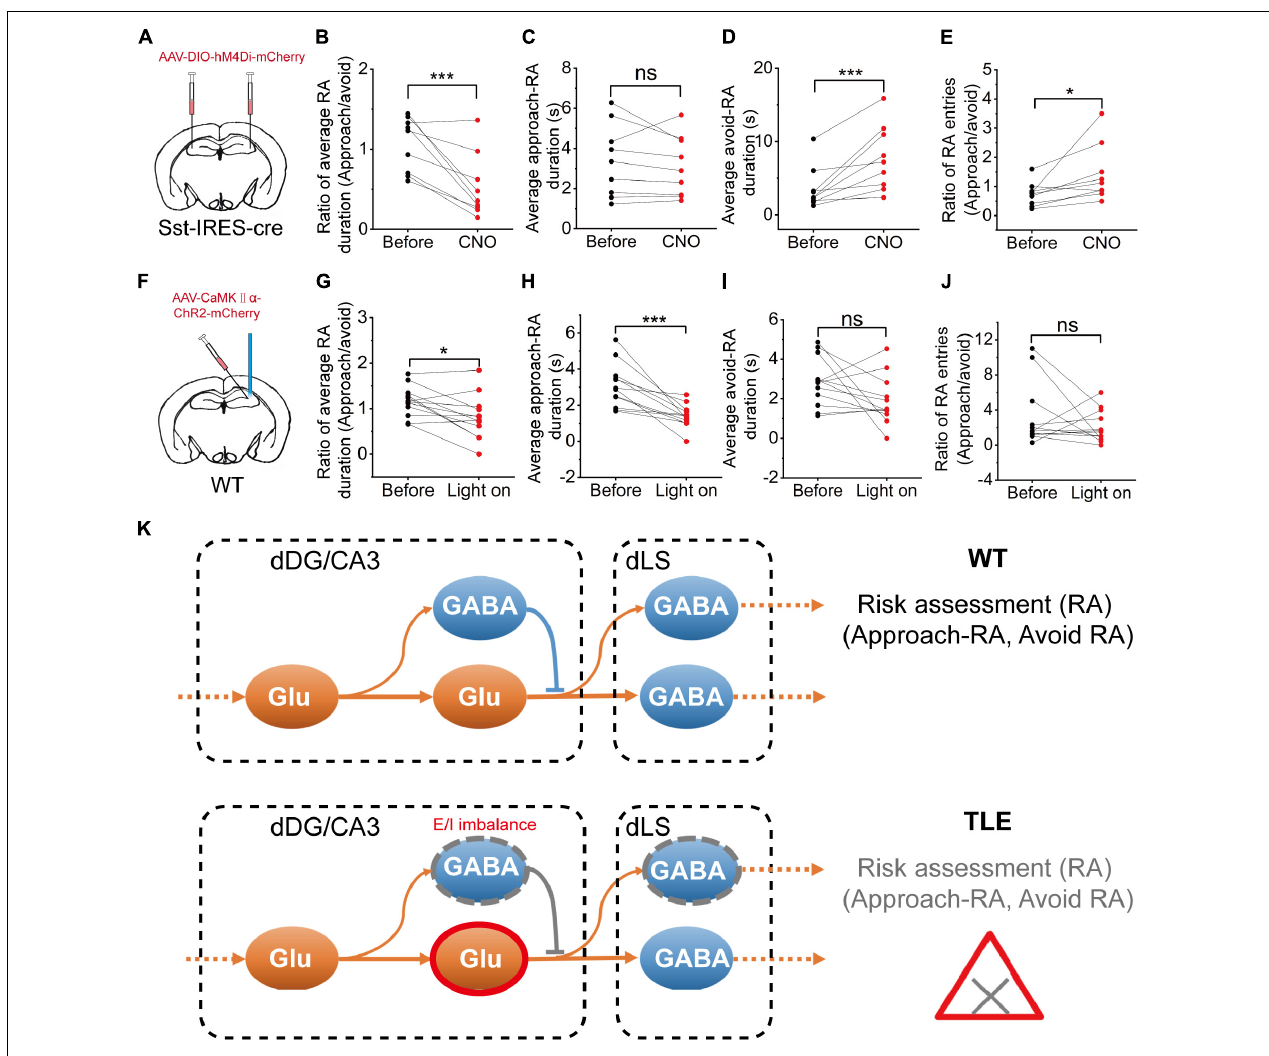
FIGURE 6 | Chemogenetic inhibition of hippocampal SOM+ neurons or optogenetic activation of CaMKII+ neurons impaired the RA of mice. (A) Diagram showing the chemogenetic inhibition of CA3 SOM+ neurons; (B) Ratio between the mean approach- and avoid-RA durations; (C) Average approach-RA duration; (D) Average avoid-RA duration; (E) Ratio between approach- and avoid-RA entries (before CNO, n = 9; CNO, n = 9; error bars represent standard deviation (s.d.); * p < 0.05; *** p < 0.001, paired t -test); (F) Diagram of the experimental setup for optogenetic stimulations; (G–J) Optogenetic activation of hippocampal glutamatergic neurons; (G) Ratio between the mean approach- and avoid-RA durations; (H) Average approach-RA duration; (I) Average avoid-RA duration; (J) Ratio between approach- and avoid-RA entries (before light, n = 12; light on, n = 12; error bars represent standard deviation (s.d.); *** p < 0.001, paired t -test); and (K) A supposed model of neural E/I imbalance mechanism in impairment of approach-RA in TLE. ns, no significant